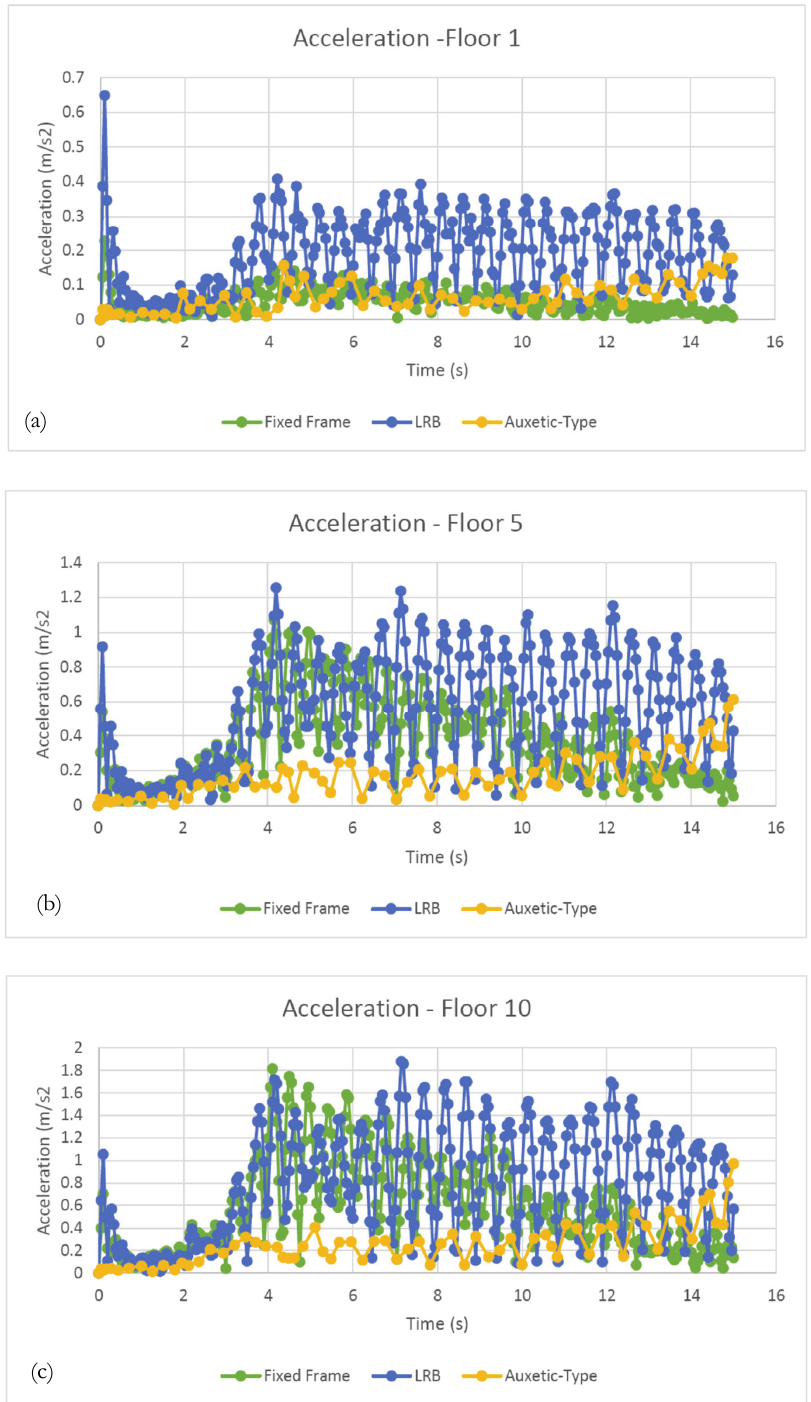
Figure 16: Acceleration on floor (a) 1, (b) 5, (c)